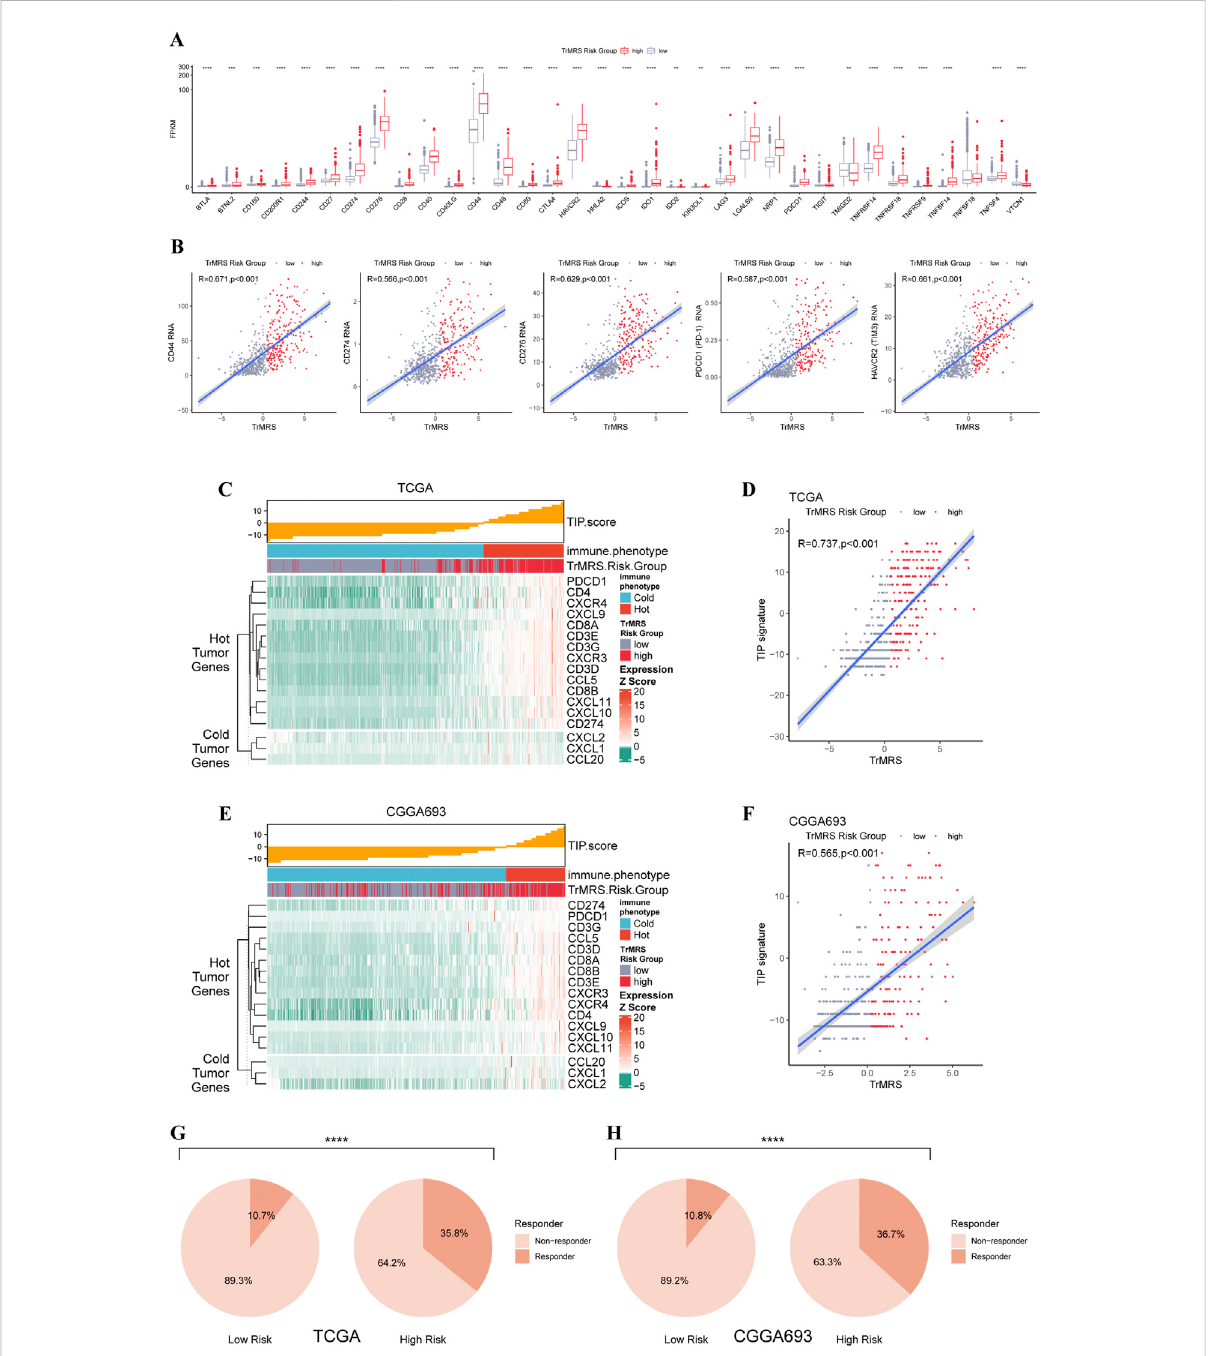
FIGURE 9 Differences in expression of immunotherapy targets and response to ICIs between two TrMRS risk groups. (A) The expression level of 34 immunotherapy-related genes in two risk groups (low-risk group: N = 429, high-risk group: N = 226). (B) Analyses of correlations of TrMRS with the expression of CD44, CD274, CD276, and PDCD1 ( N = 655). (C) TIP scores and related gene expression levels between two risk groups in TCGA dataset. (D) AnalysesofcorrelationsofTrMRSwiththeTIPscoreinTCGAdataset. (E) TIPscoresandrelatedgeneexpressionlevelsbetweentwo risk groups in CGGA dataset ( N = 415, low-risk group: N = 249, high-risk group: N = 166). (F) Analyses of correlations of TrMRS with the TIP score in CGGA dataset. (G) Percentage of predicted responders to immune checkpoint inhibitors therapy in each risk group based on TCGA dataset and (H) CGGA